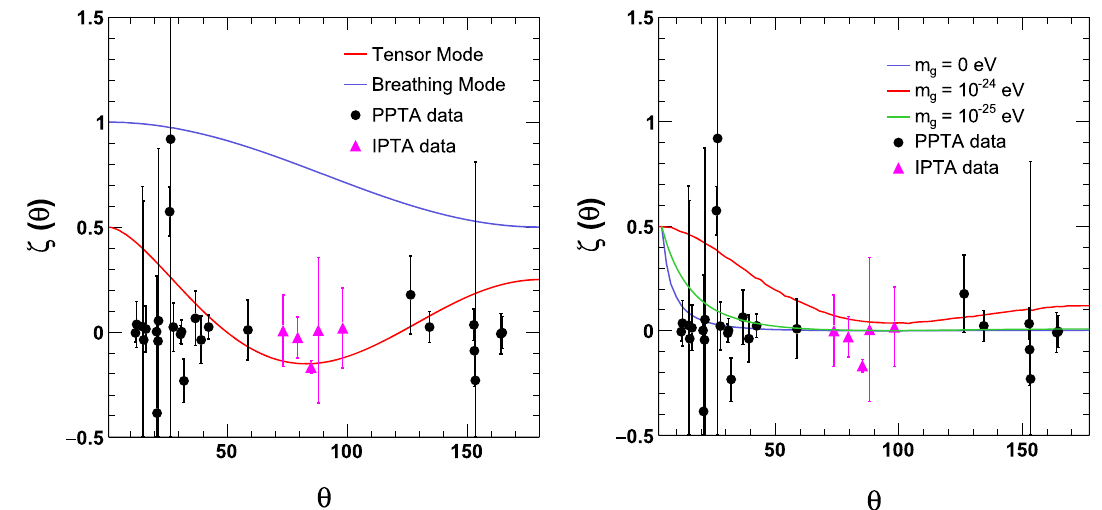
values of the mass of the mode as predicted by the model (1) along with correlation functions for some selected pulsars obtained from PPTA [42] and IPTA [47,48]